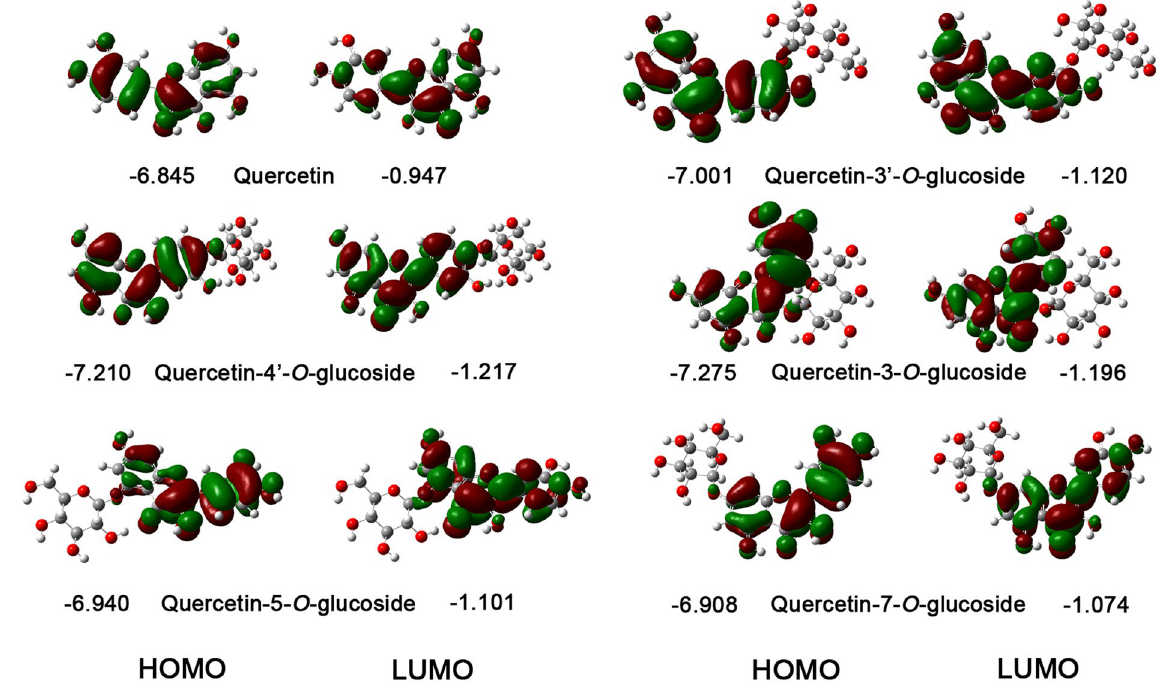
Figure 3. The energy and distribution of HOMO and LUMO for quercetin and its glucosides in the gas